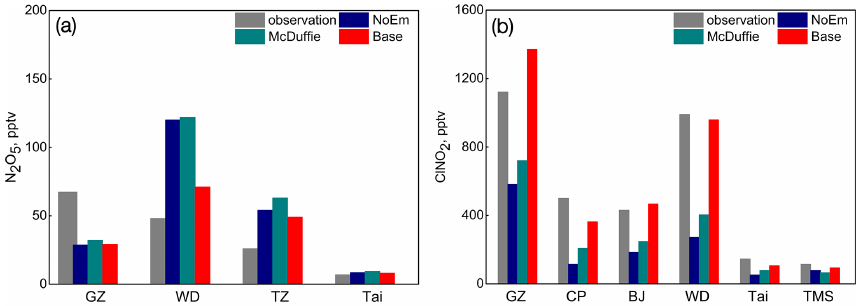
Figure 3. Comparison of observed and simulated (a) averaged N 2 O 5 concentrations and (b) mean nighttime maximum mixing ratio of ClNO 2 concentrations at different sites. The simulation definitions are provided in Table 2. GZ: Guangzhou; WD: Wangdu; TZ: Taizhou; Tai: Mount Tai; CP: Changping; BJ: Beijing; TMS: Tai Mo Shan.